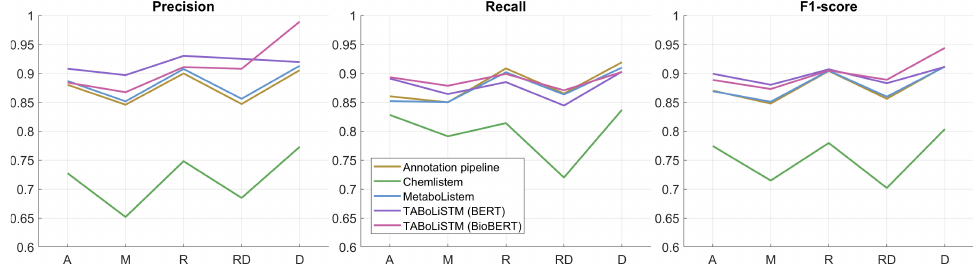
Figure 3. Model performance per publication section. The model performance (precision, recall and F1-score) are given for 5 sections (A, abstract; M, materials/methods; R, results; RD, results and discussion (as single section); D, discussion) for the 5 models.